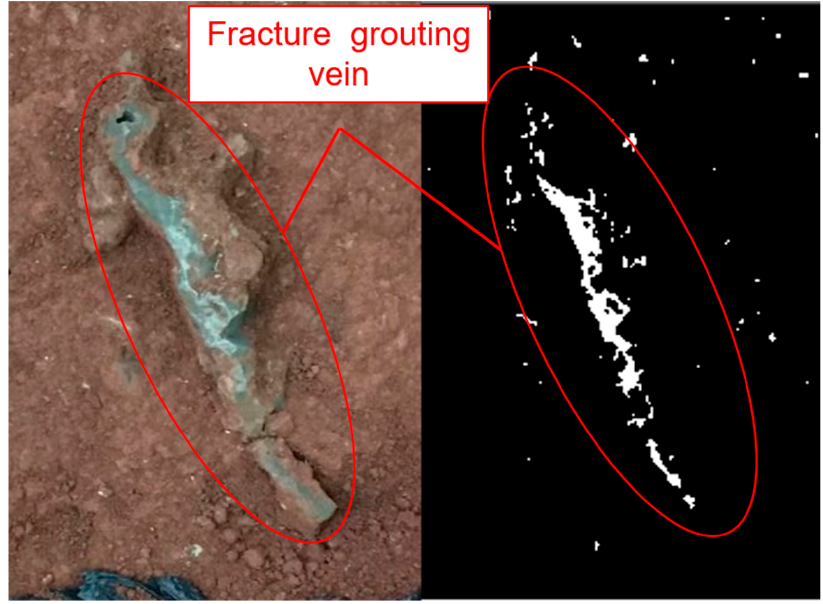
Figure 11. Part of the concretion of Group #10.